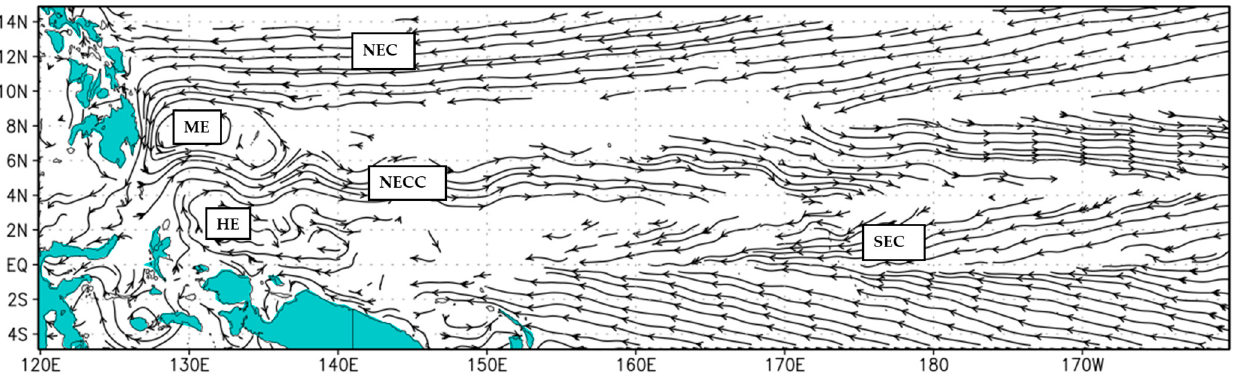
Figure 1. Outline of the principal ocean surface current and eddy phenomena in the region of Western Pacific Ocean.